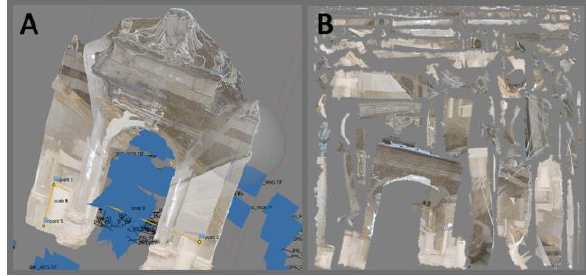
Figure 2. A) mesh model of Porta Nuova in Ravenna with incorrect automatic texturing; B) the corresponding parameterization and texture obtained automatically (photographic survey by M. El